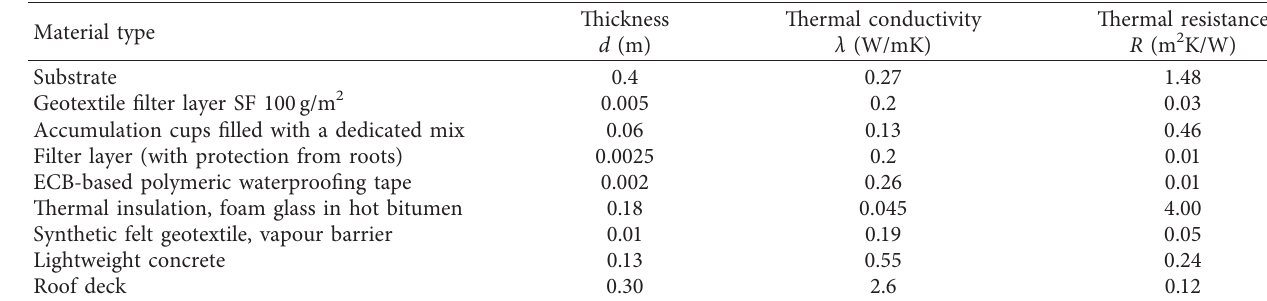
Table 3: Thermal resistance of layers of an intensive green roof (the table is structured by authors upon data collected from cost estimate for the building under construction).